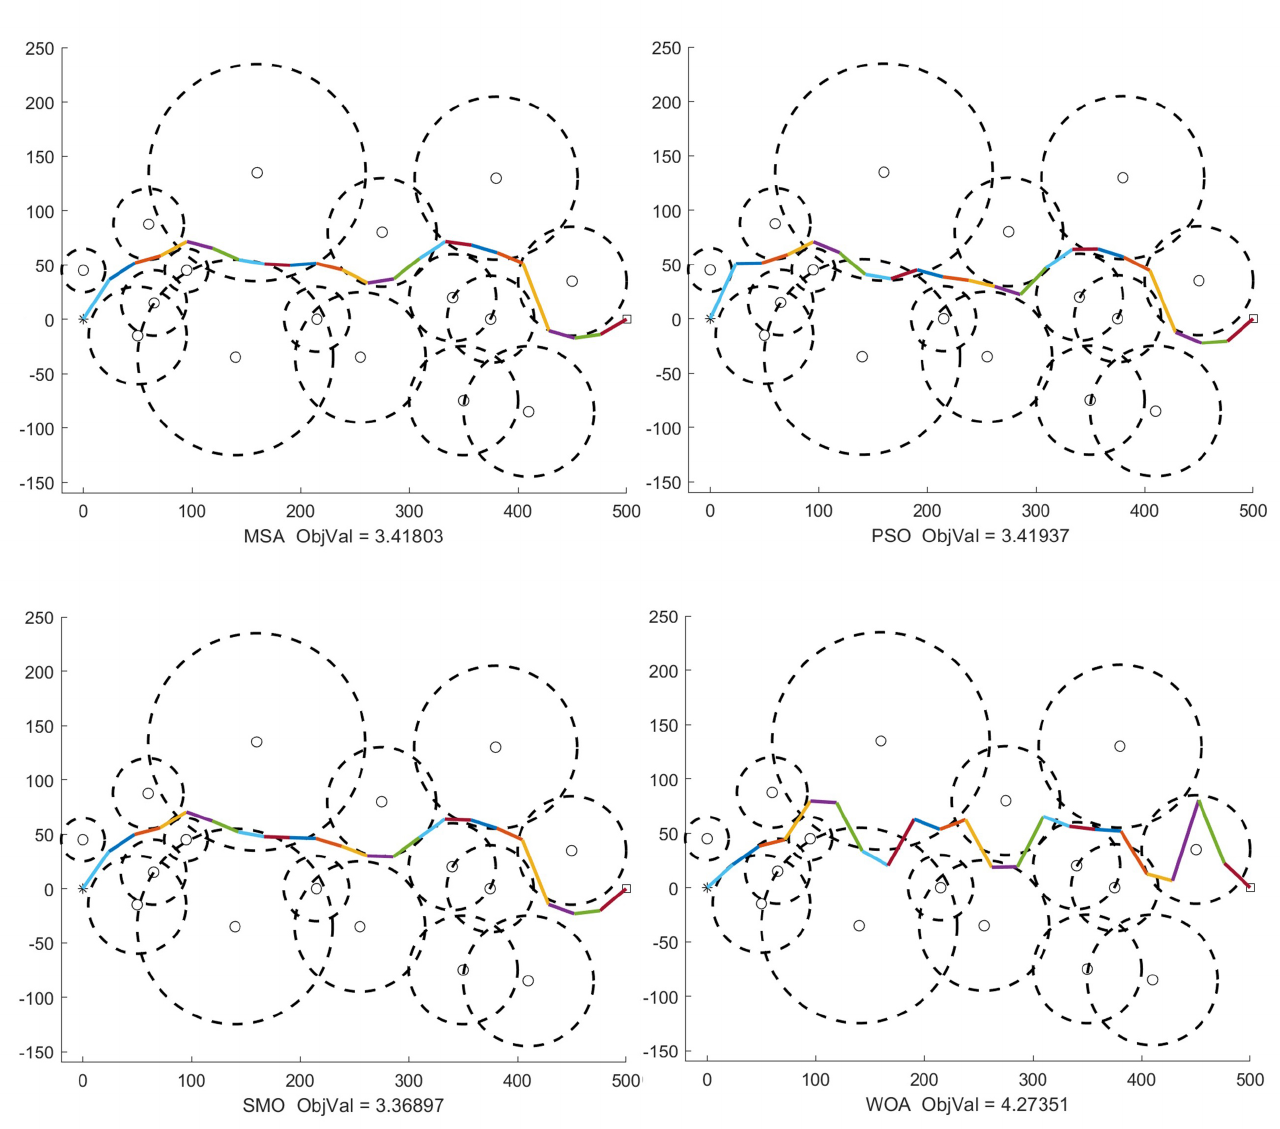
Figure 5. The comparison performance of different swarm intelligence algorithms including moth search algorithm (MSA), particle swarm optimization (PSO), spider monkey optimization (SMO), and whale optimization algorithm (WOA) for Case 8 with D = 20, N =